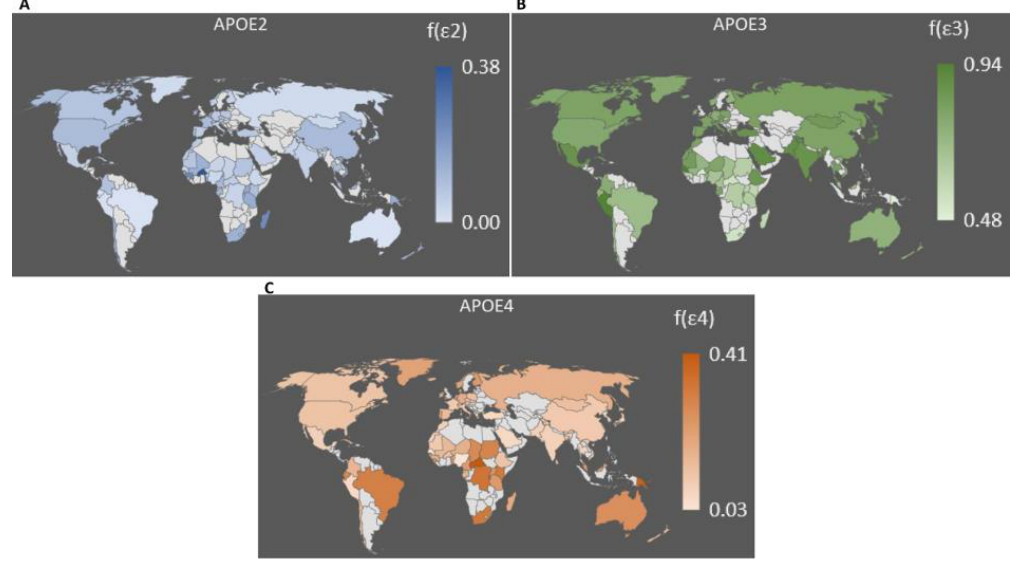
Figure 2. Frequency distribution of APOE alleles in 82 countries. Data from the 1000 Genome Project have been integrated with those published in Singh et al. 2006. ( A ) Frequency distribution of the ε2 variant. ( B ) Frequency distribution of the ε3 variant. ( C ) Frequency distribution of the ε4 variant.